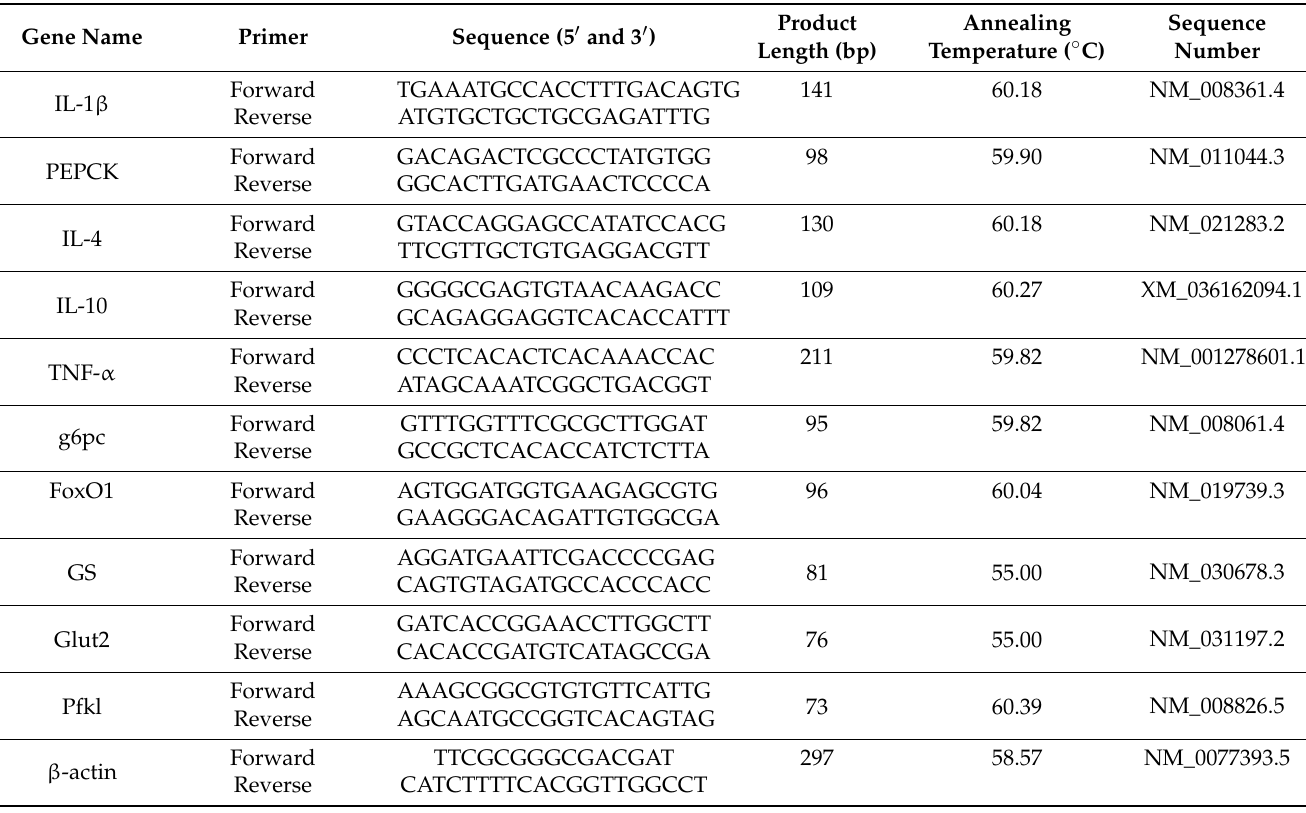
Table 2. Primers used for the real-time PCR